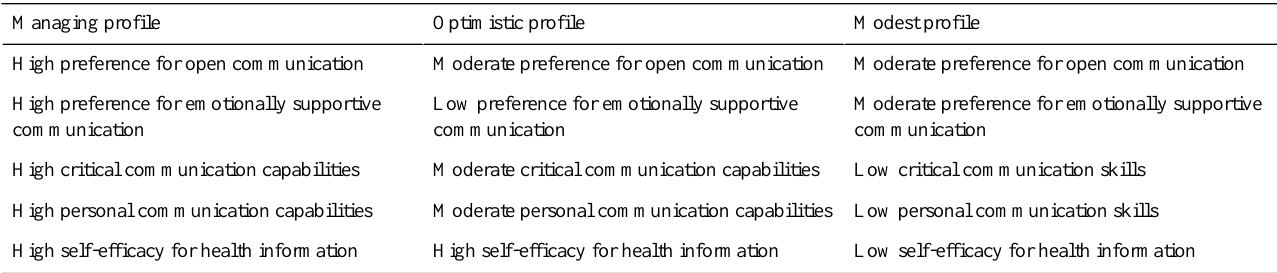
Table 1. Description of communicative preferences and capabilities of three total joint replacement patient profiles a .